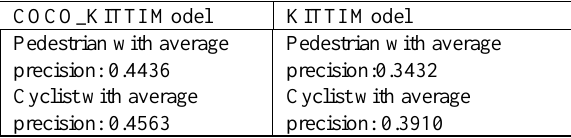
Table 1 The comparison of COCO_KITTI model and KITTI model